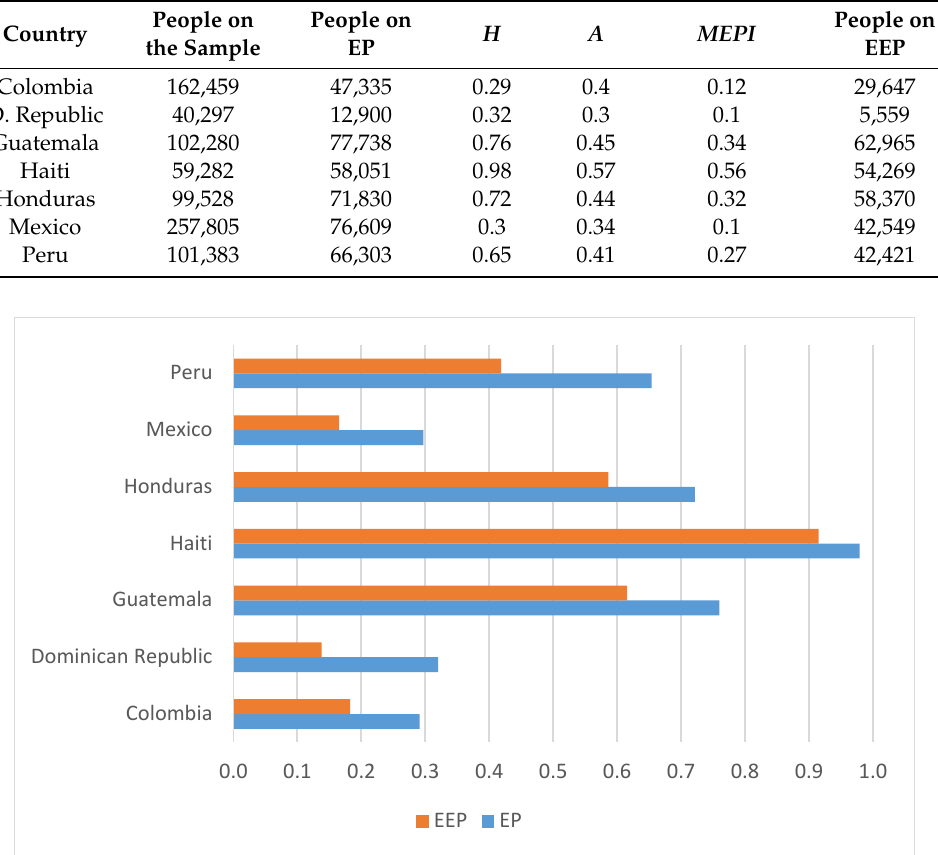
Figure 1. Share of population facing energy poverty for the evaluated countries.